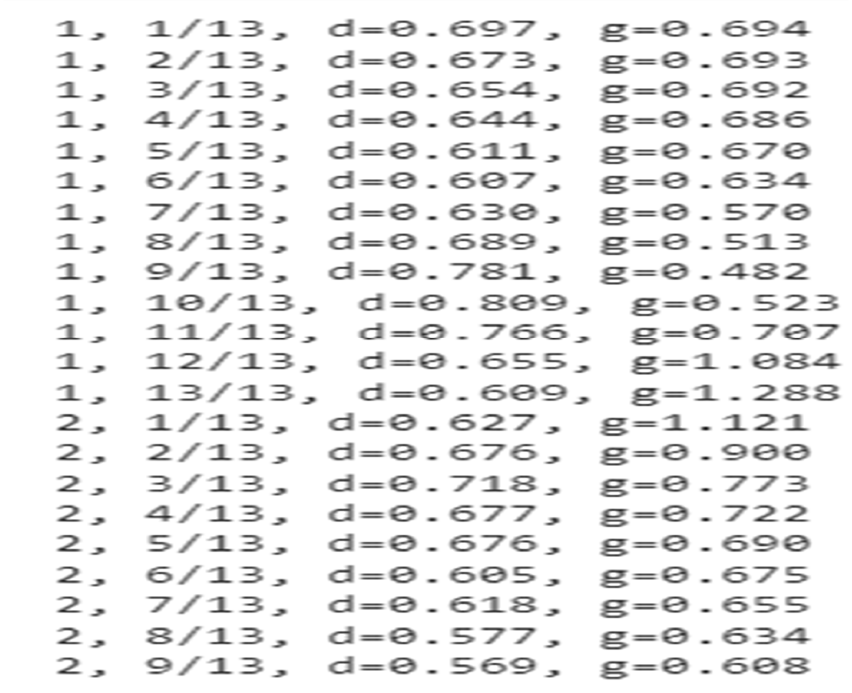
Figure 7. Parameter performance .